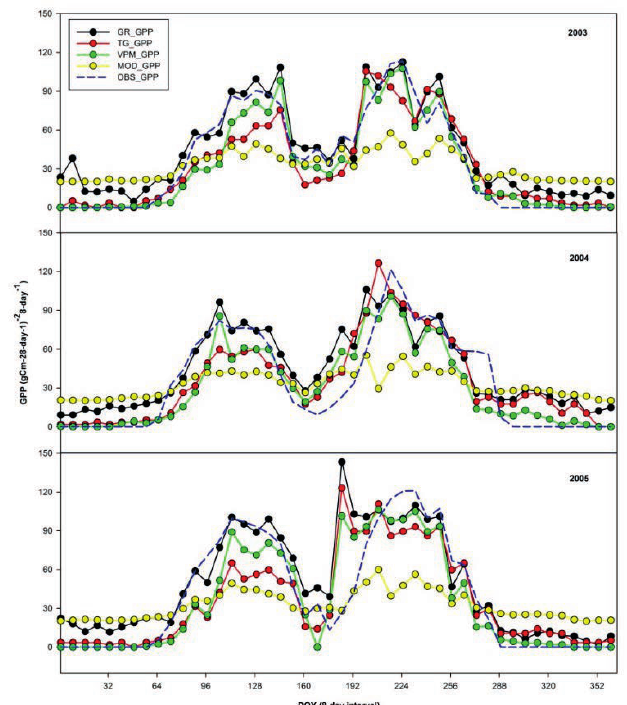
Fig. 3 The 8-day evolution of the observed GPP (OBS_GPP), MODIS GPP product (MOD_GPP), GPP simulated by GR model (GR_GPP), GPP simulated by TG model (TG_GPP), and GPP simulated by VPM model (VPM_GPP) in Yucheng site from 2003 to